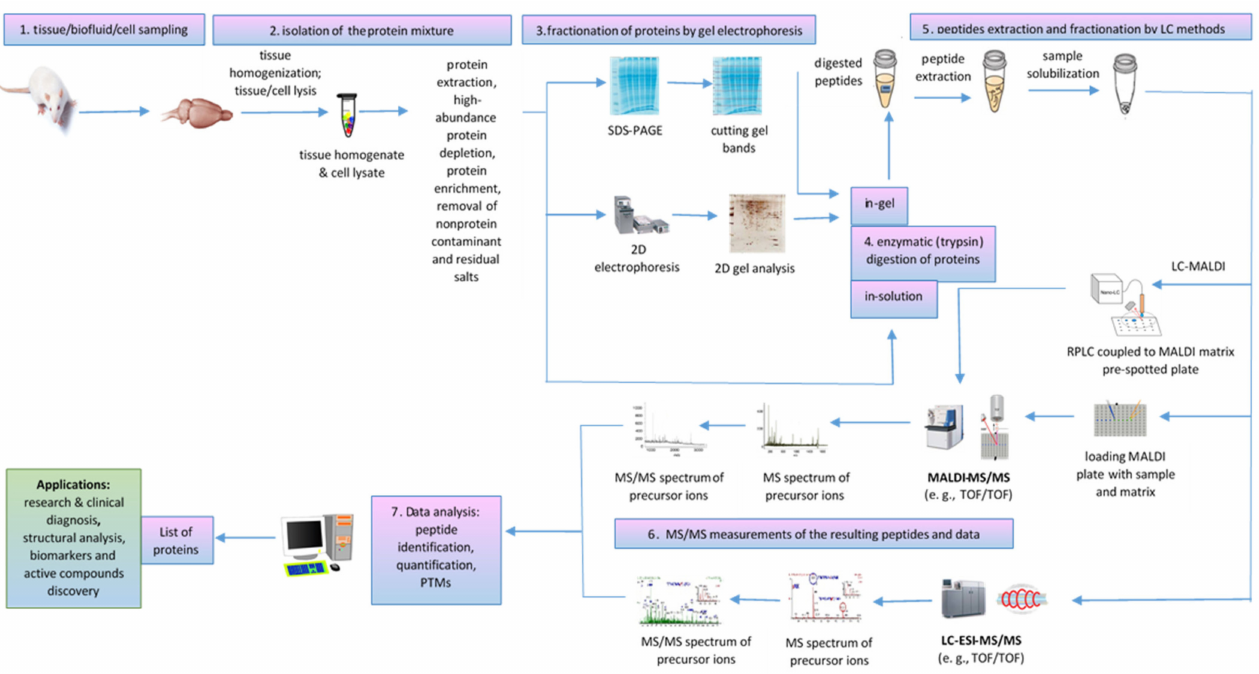
Figure 6. MALDI MS/MS proteomics workflow for tissue homogenates/cell lysates and biofluid